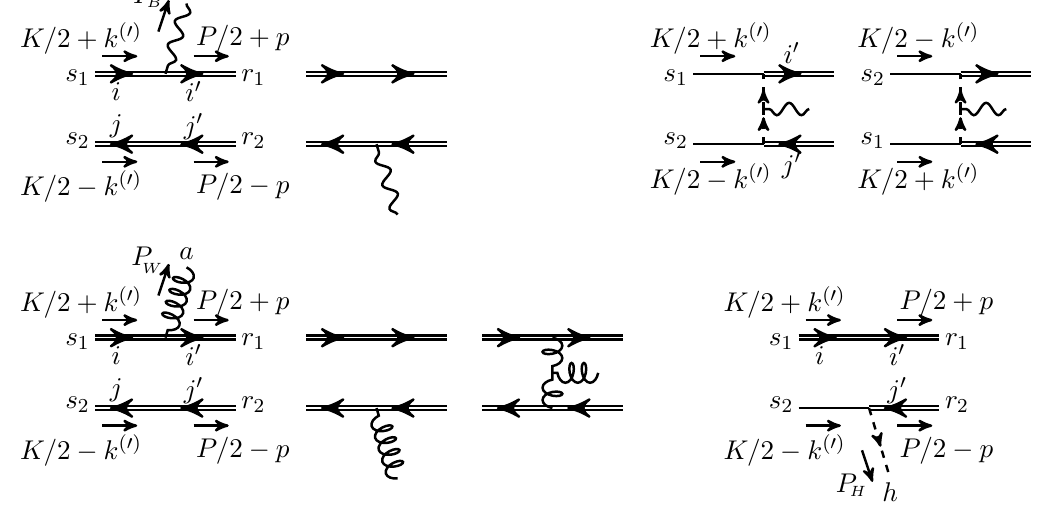
¯ ¯ ¯ D bound states. Top: D D -like → B ( D D )+ B